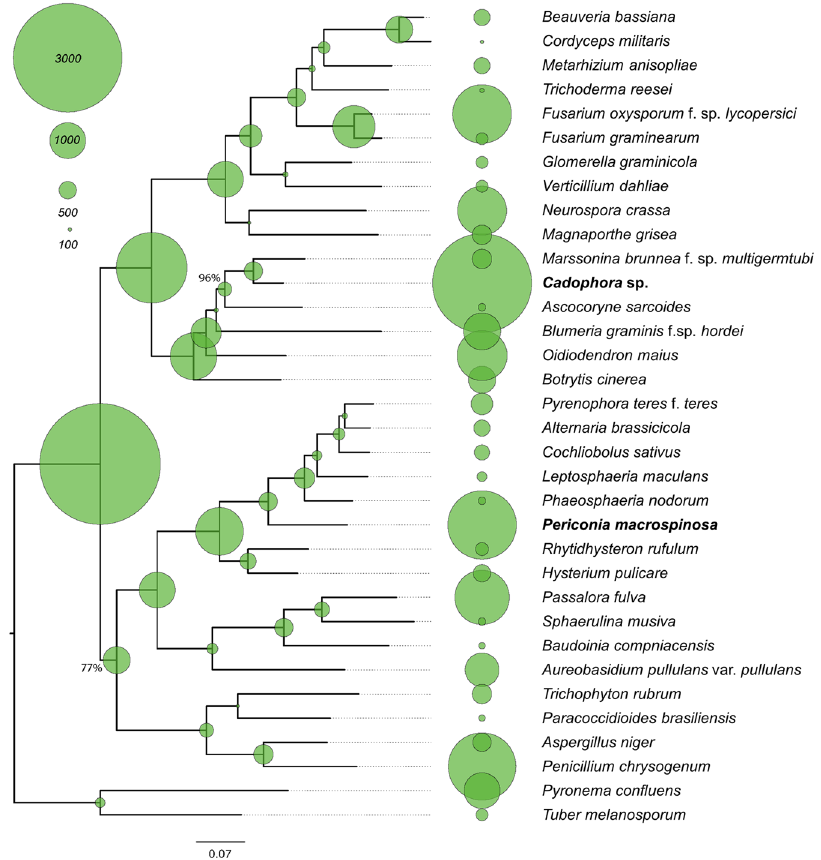
Figure 3. Genome-wide reconstruction of gene duplication histories of Cadophora sp., Periconia macrospinosa and another 32 ascomycetes. Green circles indicate observed (on terminal branches) and reconstructed (on internal nodes) copy numbers. The two DSEs are marked in